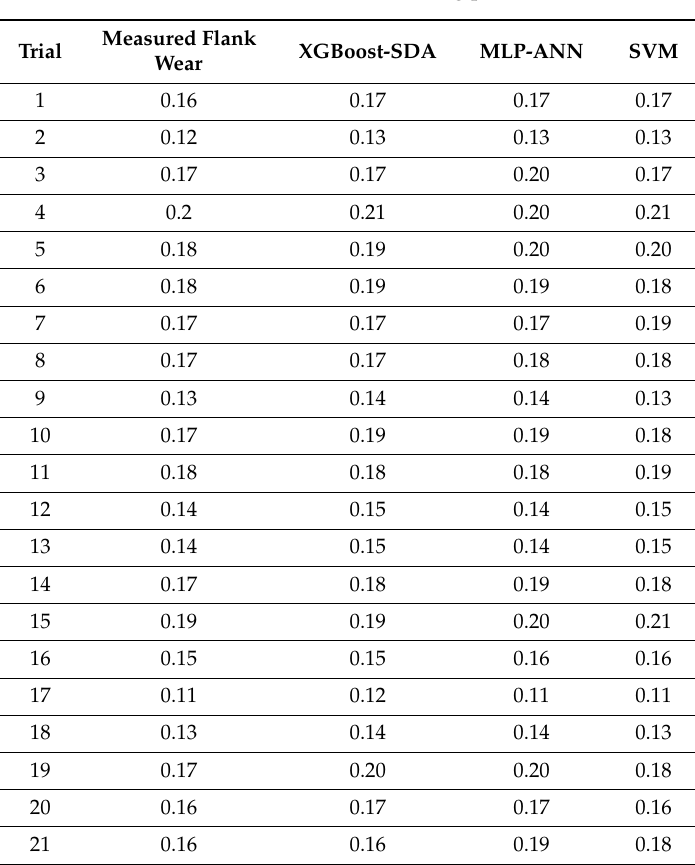
Table 9. Prediction results of the flank wear in drilling process (Cast Iron